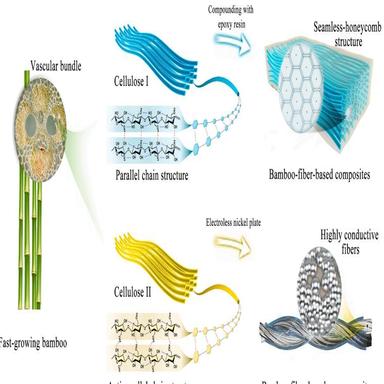
Schematic showing the design concept and fabrication process of bamboo fiber-based composites and supercapacitors.